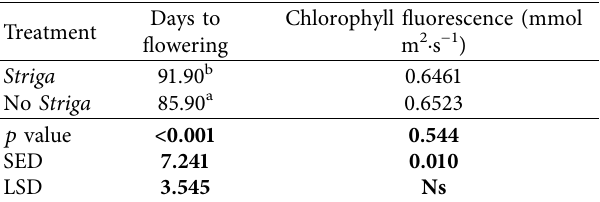
Means followed by the different letters in the column are significantly different at p < 0 .